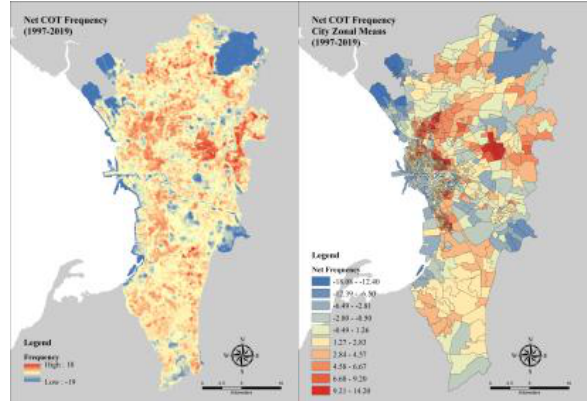
Figure 5. Net Cluster and Outlier Type (COT) Frequency maps of Metro Manila for years 1997 to 2019. (a) Raster (100-meter resolution), (b) City Zonal